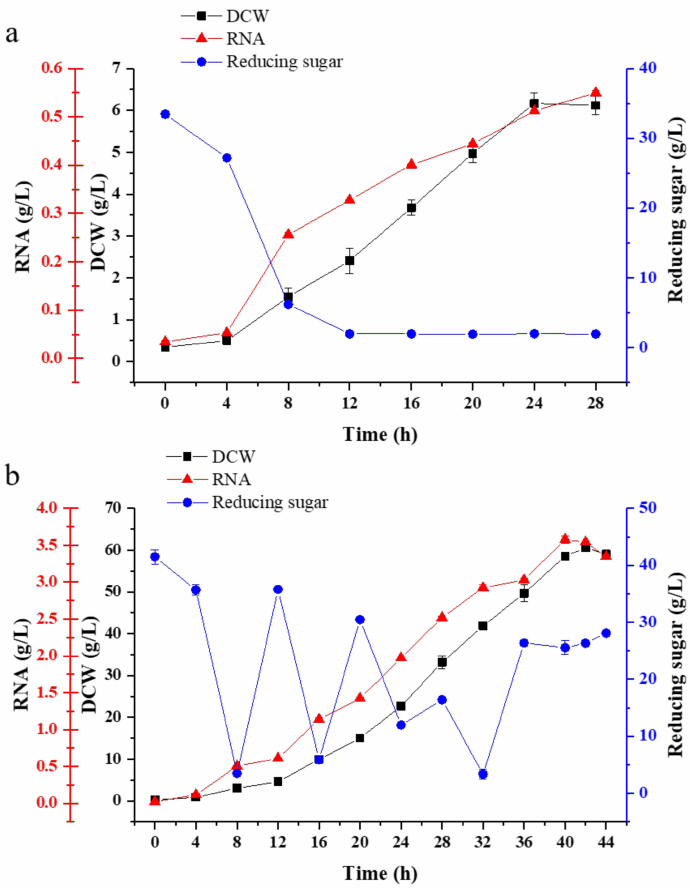
Figure 6. Production synthesis and changes in reducing sugar consumption of G03H8 in batch ( a ) and fed-bath ( b ) fermentation. Data are the average of three independent experiments. Error bars represent ±